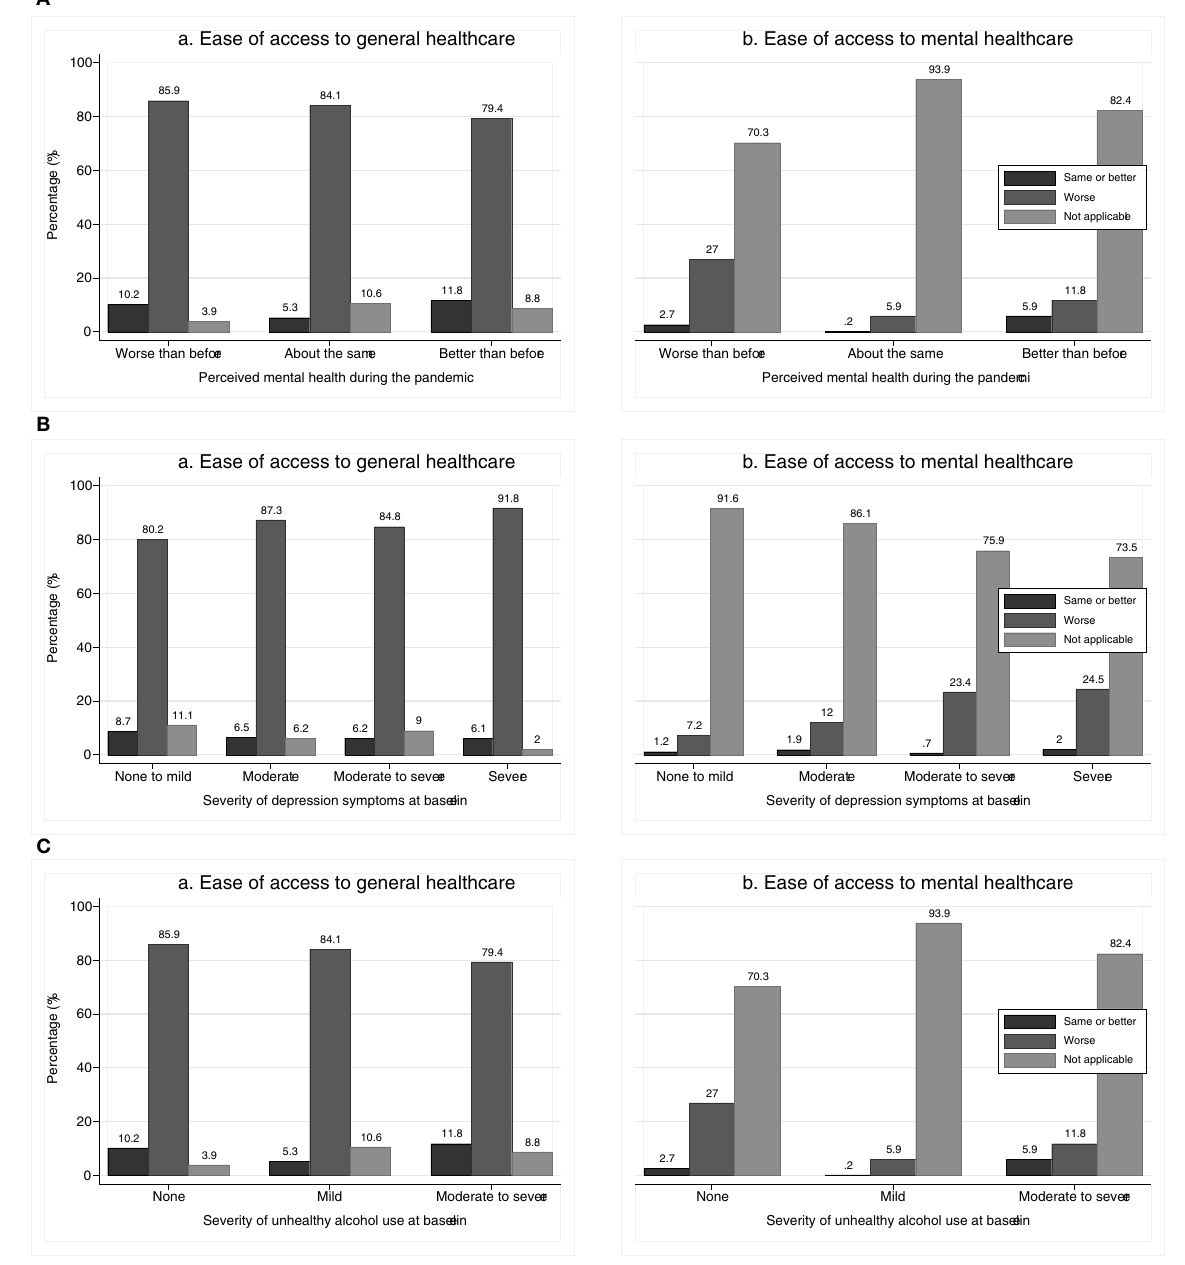
FIGURE1 (A) Perceived ease of access (a) general and (b) mental healthcare during COVID-19, compared to before, according to perceived mental health during the pandemic a . (B) Perceived ease of access (a) general and (b) mental healthcare during COVID-19, compared to before, according to severity of depression symptoms at baseline b . (C) Perceived ease of access (a) general and (b) mental healthcare during COVID-19, compared to before, according to severity of unhealthy alcohol use at baseline c . a Two participants who did not assess their perceived mental health